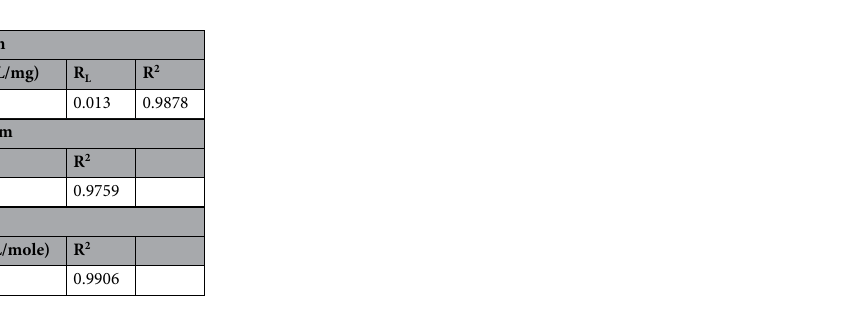
Table 2. Isotherm constants for MB dye adsorption onto 50 mg AC500/NZ at 25 °C and pH 7.